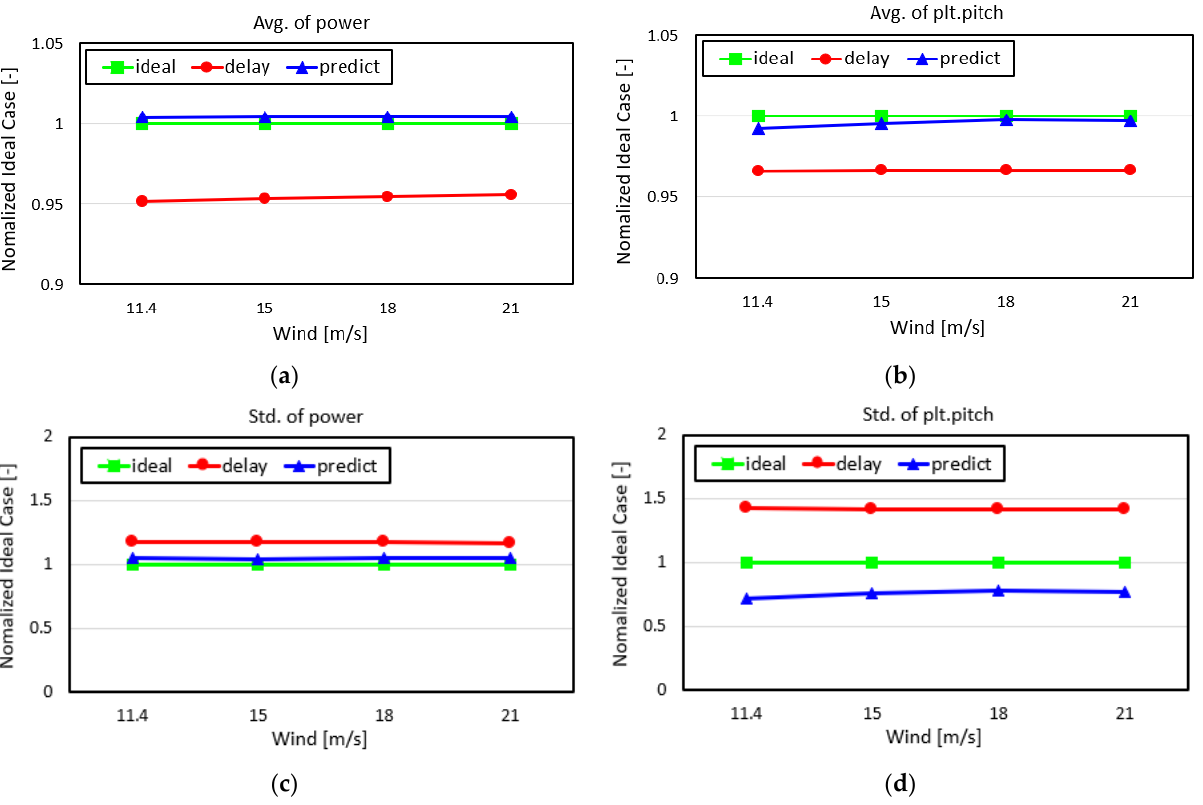
Figure 19. Average values of ( a ) power and ( b ) platform pitch and standard deviations of ( c ) power and ( d ) platform pitch according to pitch controller.